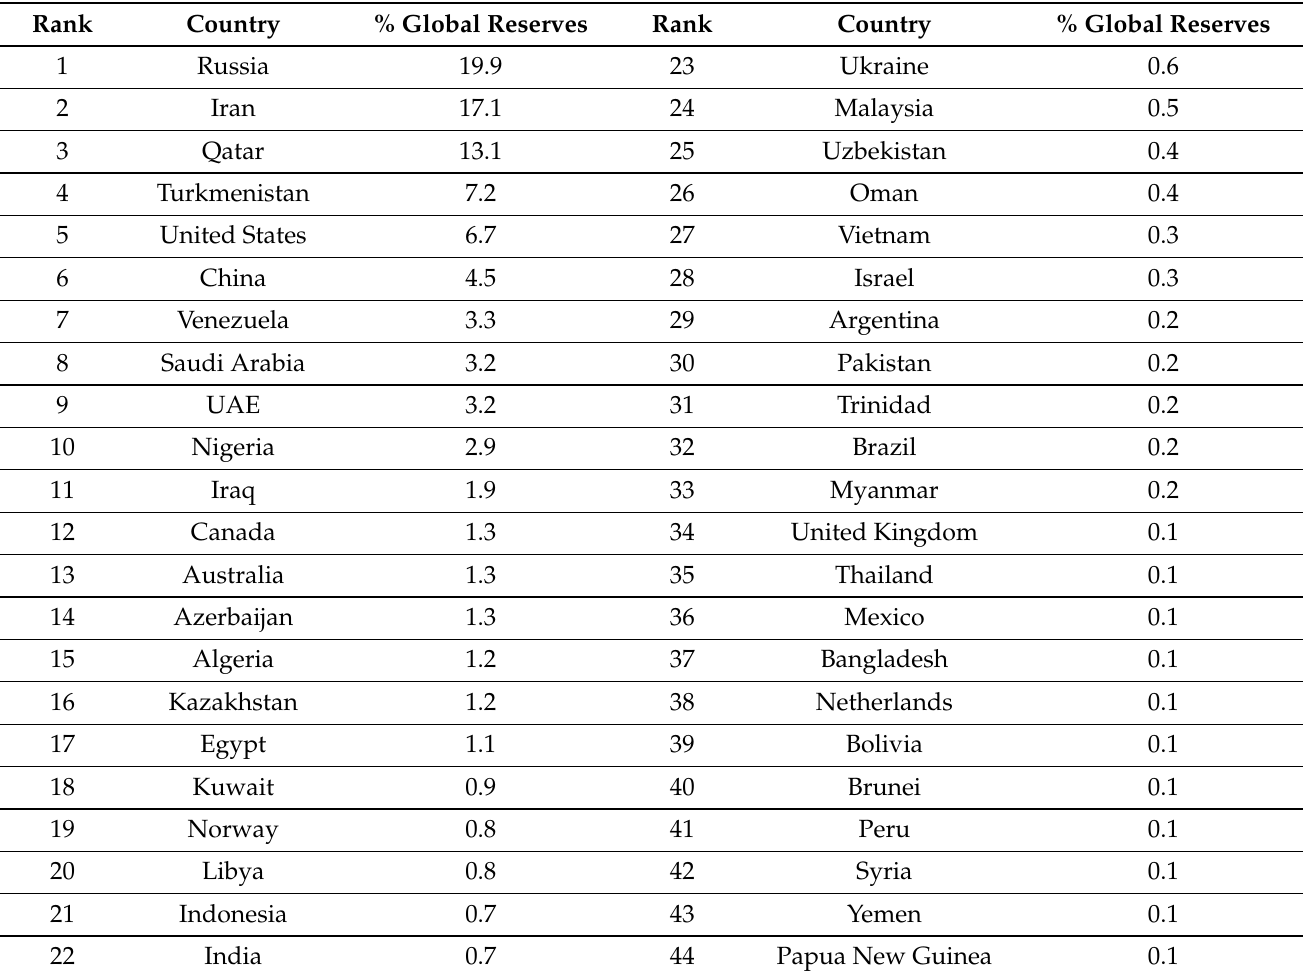
Table 7. The percent Global Reserves Natural Gas of the Countries (2020).